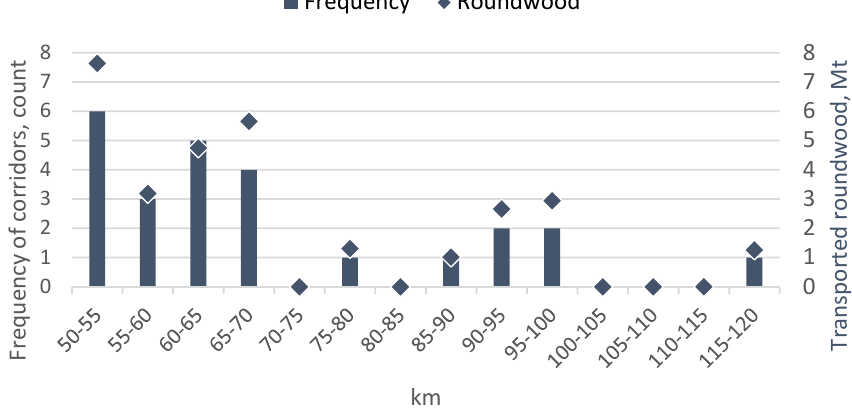
Figure 7. Frequency distribution and amount of roundwood transported (within reach of the model) by HCT corridor length. The left Y-axis is number of corridors, right Y-axis is amount of transported roundwood (Mt) and X-axis is the length of corridors (km).